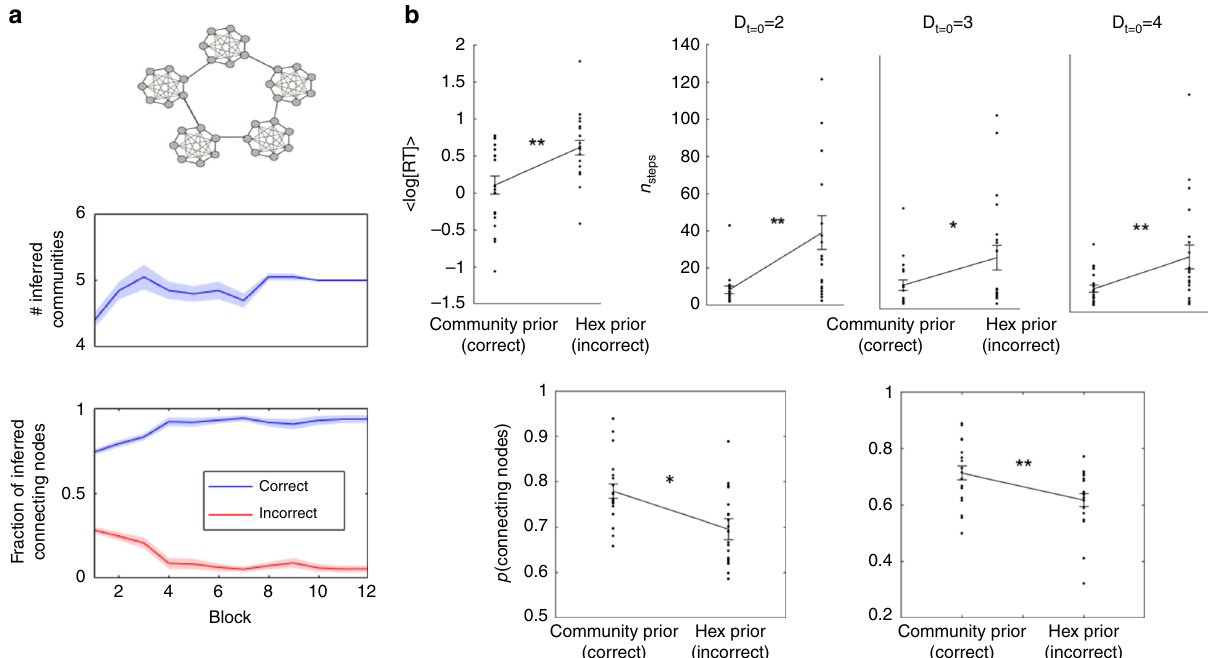
Fig. 6 Policy transfer: learning graphs with underlying community structure. a Our agent was able to infer the correct number of communities (middle panel, averaged inferred number of communities over 20 simulations). It was also able to infer the identities of the connecting nodes (lower panel, inferred number of nodes divided to the number of connecting nodes according to the inferred graph size, see ‘ Methods ’ ). Shadows are the SEM, the centre is the mean. b Participants with correct structural prior spend less time on learning the associations between the pictures (RT = response time for changing to the next pair, upper panel — left). The number of steps to the target ( n steps ) is signi fi cantly lower for participants with the correct structural prior (upper panels, D t = 0 is the initial number of links between the current picture and the target). During navigation, participants with the correct prior over the structural forms choose connecting nodes more frequently (lower panel — left), they do so even if this choice takes them far away from the target (lower panel — right). Error bars are the SEM, the centre is the mean. * p < 0.05, ** p < 0.01 (20 participants in each